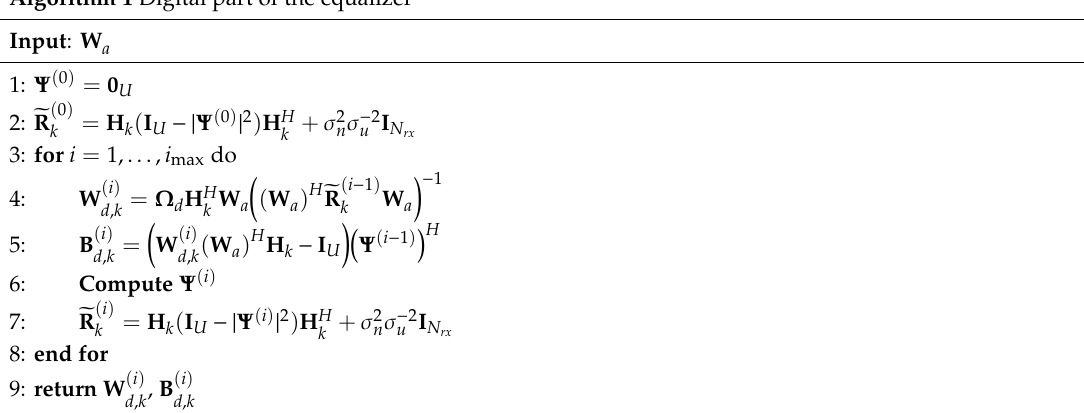
Algorithm 1 Digital part of the